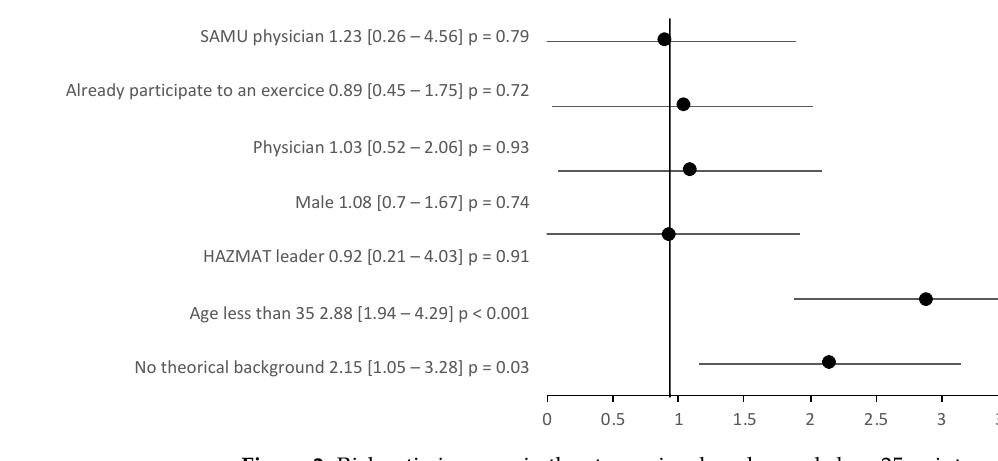
Figure 2. Risk ratio increase in the stress visual analog scale by >25 points.